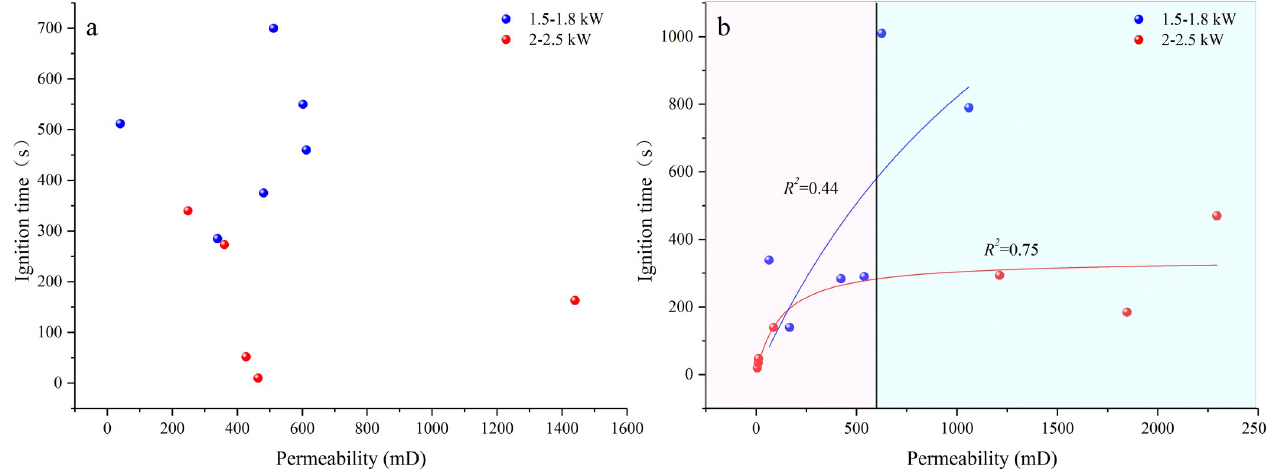
Fig 12. Relationship between sample permeability and ignition time. (a) dry samples; (b) water-saturated samples.